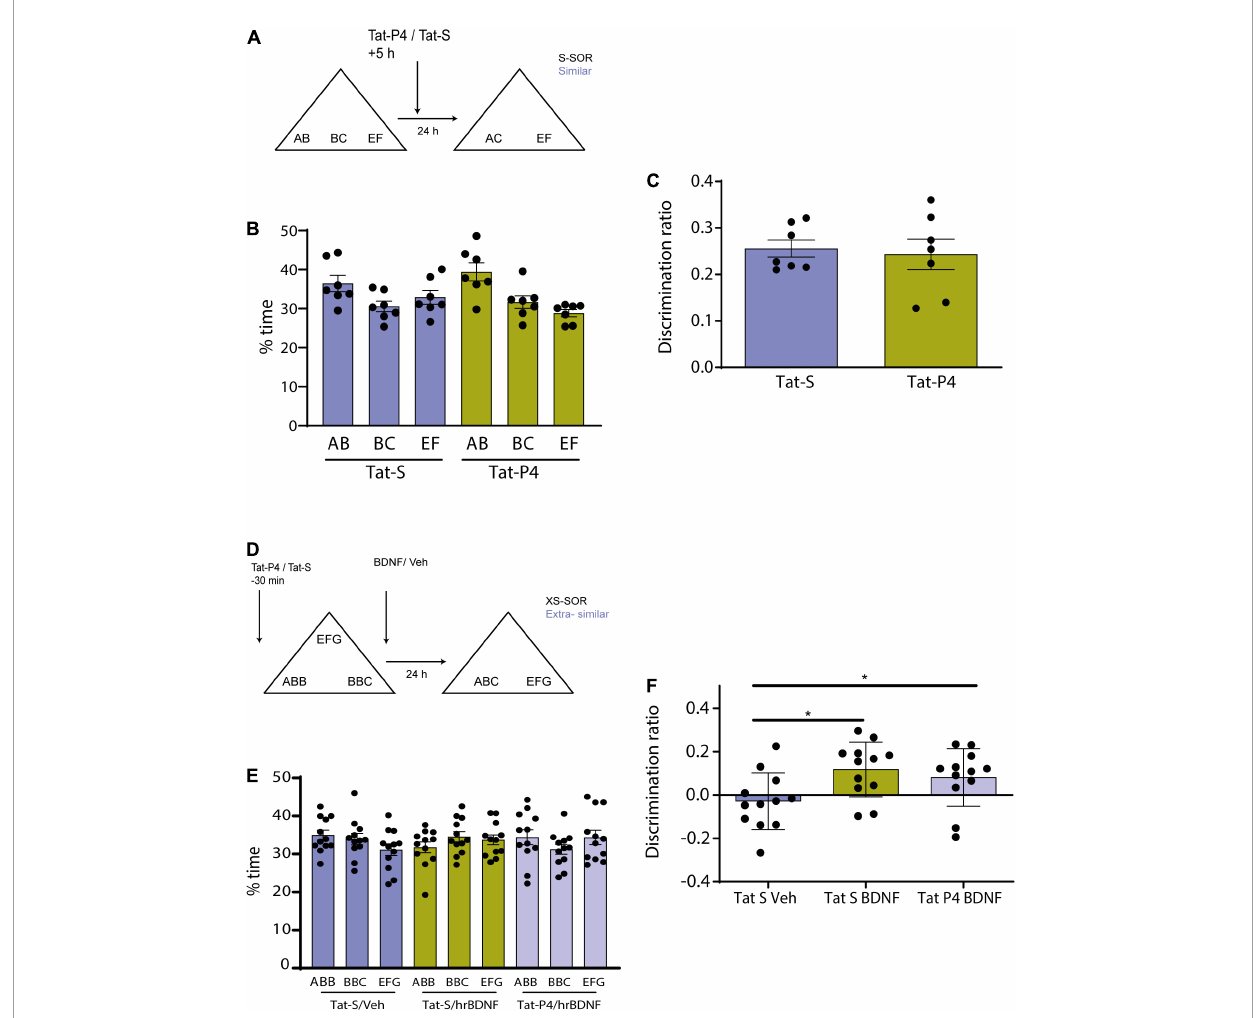
FIGURE3 (A) Schematic illustration of the similar-spontaneous object recognition task (s-SOR) task indicating infusion of Tat-P4/Tat-S 5 hs after the sample phase. (B) Percentage of time spent exploring each of the objects in the sample phase. Repeated-measures two-way ANOVA (%time) F = 2.400, pdrug = 0.1723, F = 6.509, pobject = 0.0122, F = 01.608, pinteraction = 0.2407. (C) No memory impairment found in animals between conditions [Tat-S vs. Tat-P4 paired t -test ( t = 0.2985), p = 0.7754, n = 7]. Both animal groups learned the task [One-sample t -test (Tat-S, t = 13.88), p < 0.0001; one- sample t -test (Tat-P4, t = 7.377), p = 0.0003]. (D) Schematic illustration of the extra similar condition of the task (xs-SOR) indicating the time points at which Tat-P4 or Tat-S and hrBDNF or vehicle were infused 30 min before sample phase and immediately after sample phase, respectively. (E) Percentage of time spent exploring each of the objects in the sample phase. Repeated-measures two-way ANOVA (%time), F = 1.000, pdrug = 0.1748, F = 0.1089, pobject = 0.8668, F = 1.191, pinteraction = 0.3282. (F) Repeated measures one-way ANOVA (%time), F = 3.838, pdrug = 0.0430, F = 0.7578, pindividual = 0.6757. * p < 0.05.